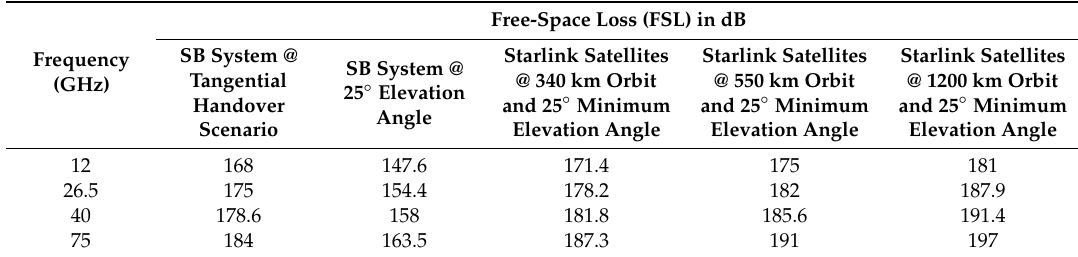
Table 3. Free-space loss (FSL) at di ff erent operating frequencies for aircraft–SB and aircraft–Starlink satellite